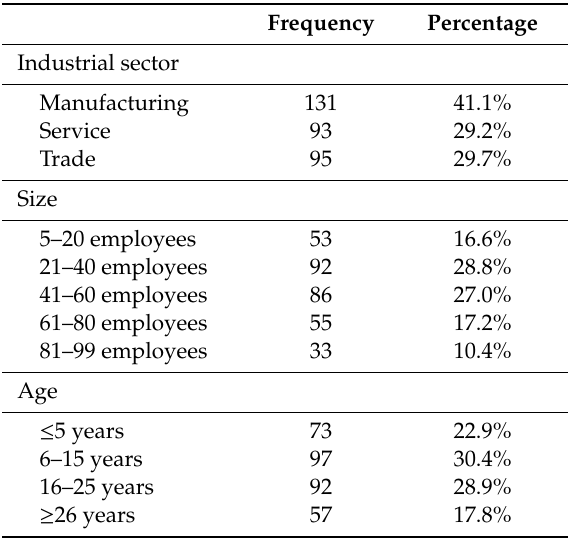
Table 1. Profile of the